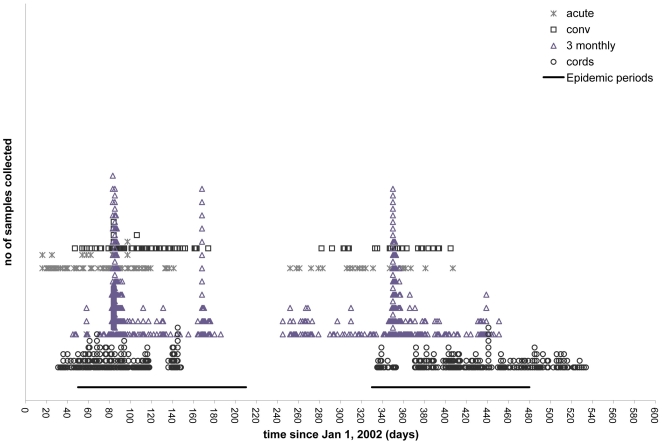
Schema of sample collection regime for Kilifi cohort.635 children were recruited to a birth cohort in 2 phases (February- May 2002, and December 2002- May 2003). Cord bloods (circles), together with sera every 3 months (triangles) were collected. Any antigen positive nasal washing detected by IFAT collected upon each ARI episode, prompted collection of paired acute (asterix) and convalescent (squares) phase sera. The first 2 epidemics experienced by the cohort are indicated by the black bars.